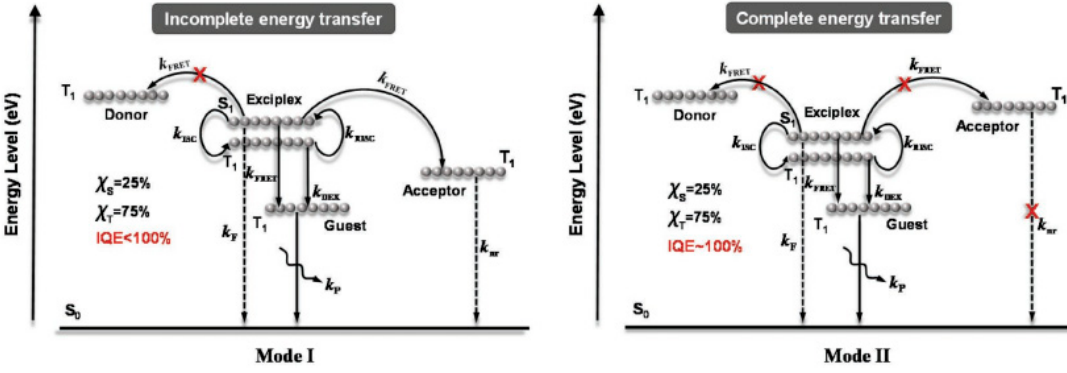
Figure 9. Two different energy-transfer modes. Donor and acceptor are the constituting molecules for exciplex. S 1 and T 1 are the singlet and triplet states, respectively. k FRET , k DEX , k ISC , k RISC , k F , and k P are the rate constant of Förster energy transfer, Dexter energy transfer, ISC, RISC, fluorescence and phosphorescence processes, respectively. Reproduced from Reference [12].